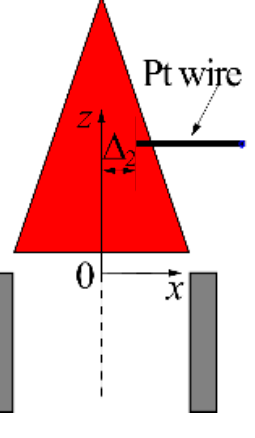
Figure 6. Schematic of the electrode structure for the experiments of Factor 3. Table 5. Experimental conditions for Factor 3. Parameter